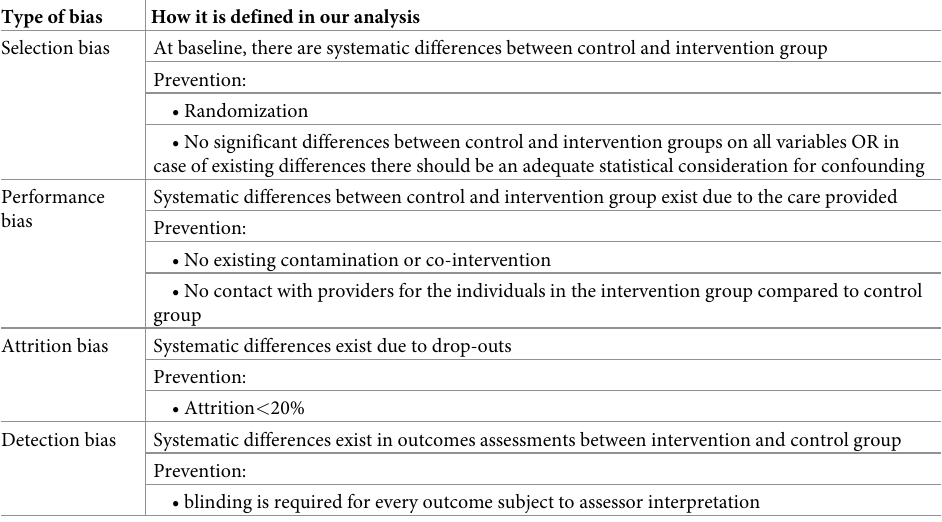
Table 2. Tool to assess internal validity based on the Cochrane methodology [26].